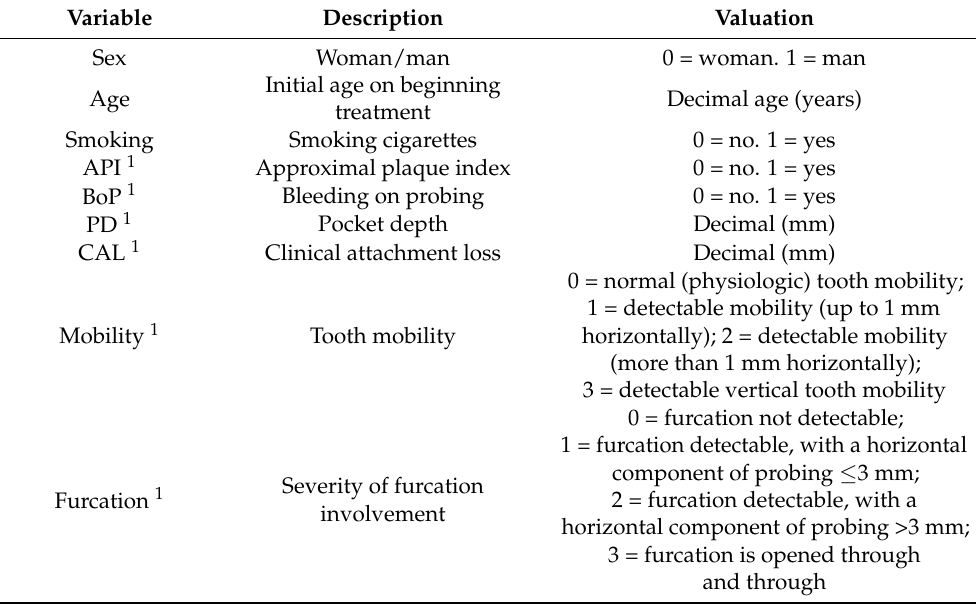
Table 1. Variables represented on the